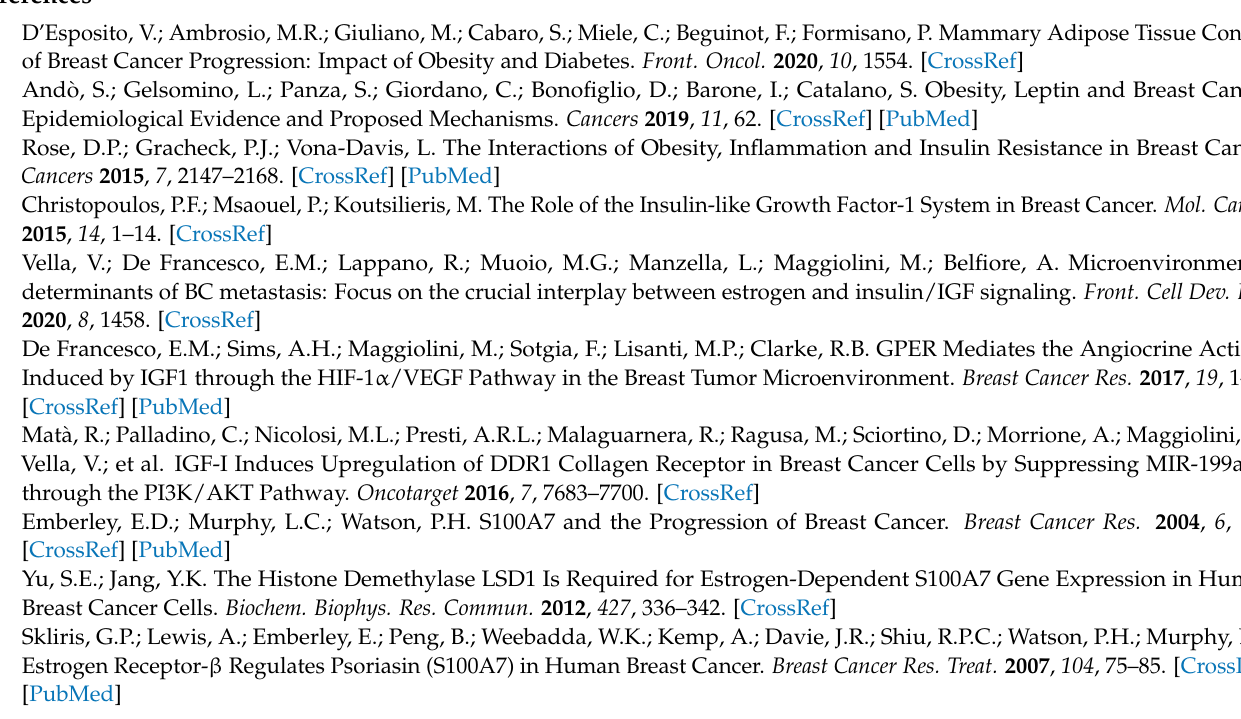
and densitometric analyses relative to Figure 2. Figure S4: Original Western blots and densitometric analyses relative to Figure 3. Figure S5: Original Western blots and densitometric analyses relative to Figure 4. Figure S6: Original Western blots and densitometric analyses relative to Figure 5. Figure S7: Original Western blots and densitometric analyses relative to Figures 7 and 8. Figure S8: Original Western blots and densitometric analyses relative to Figure